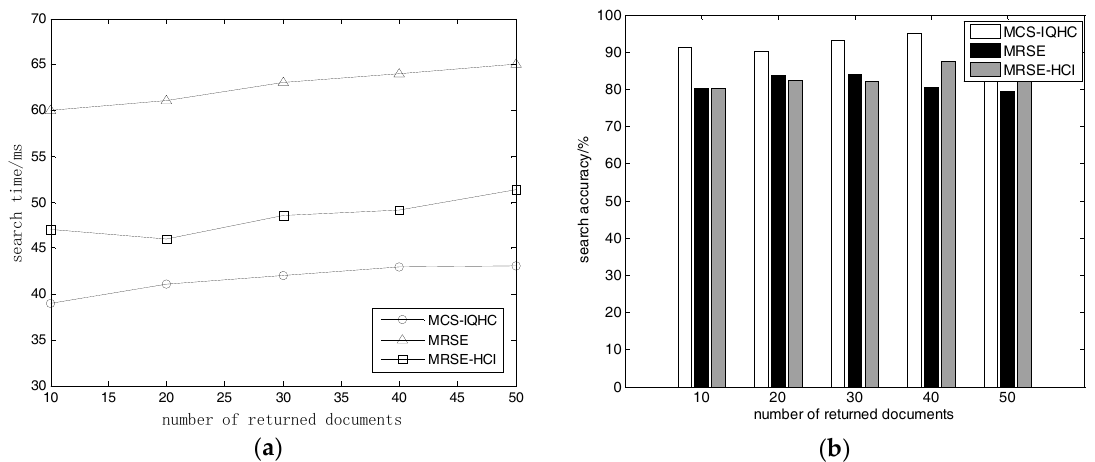
Figure 3. ( a ) Relationship between quantity of returned documents and search time; ( b ) Relationship between quantity of returned documents and search accuracy.